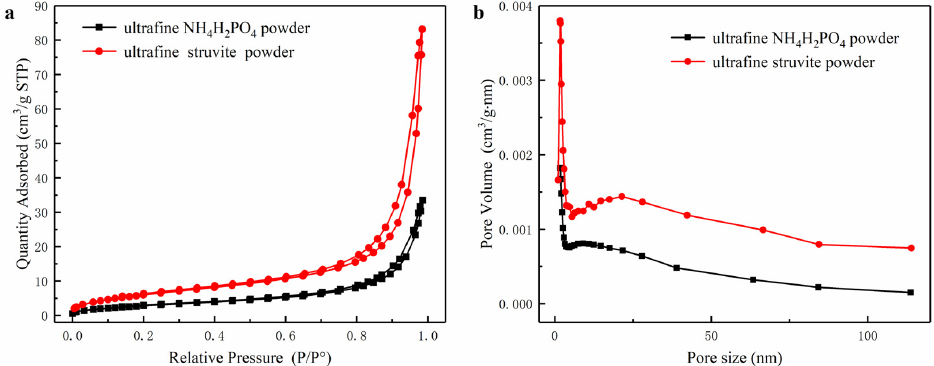
Figure 5. ( a ) Pore size distribution of samples, ( b ) Adsorption and desorption curves of samples. Table 1. Particle size and BET of two